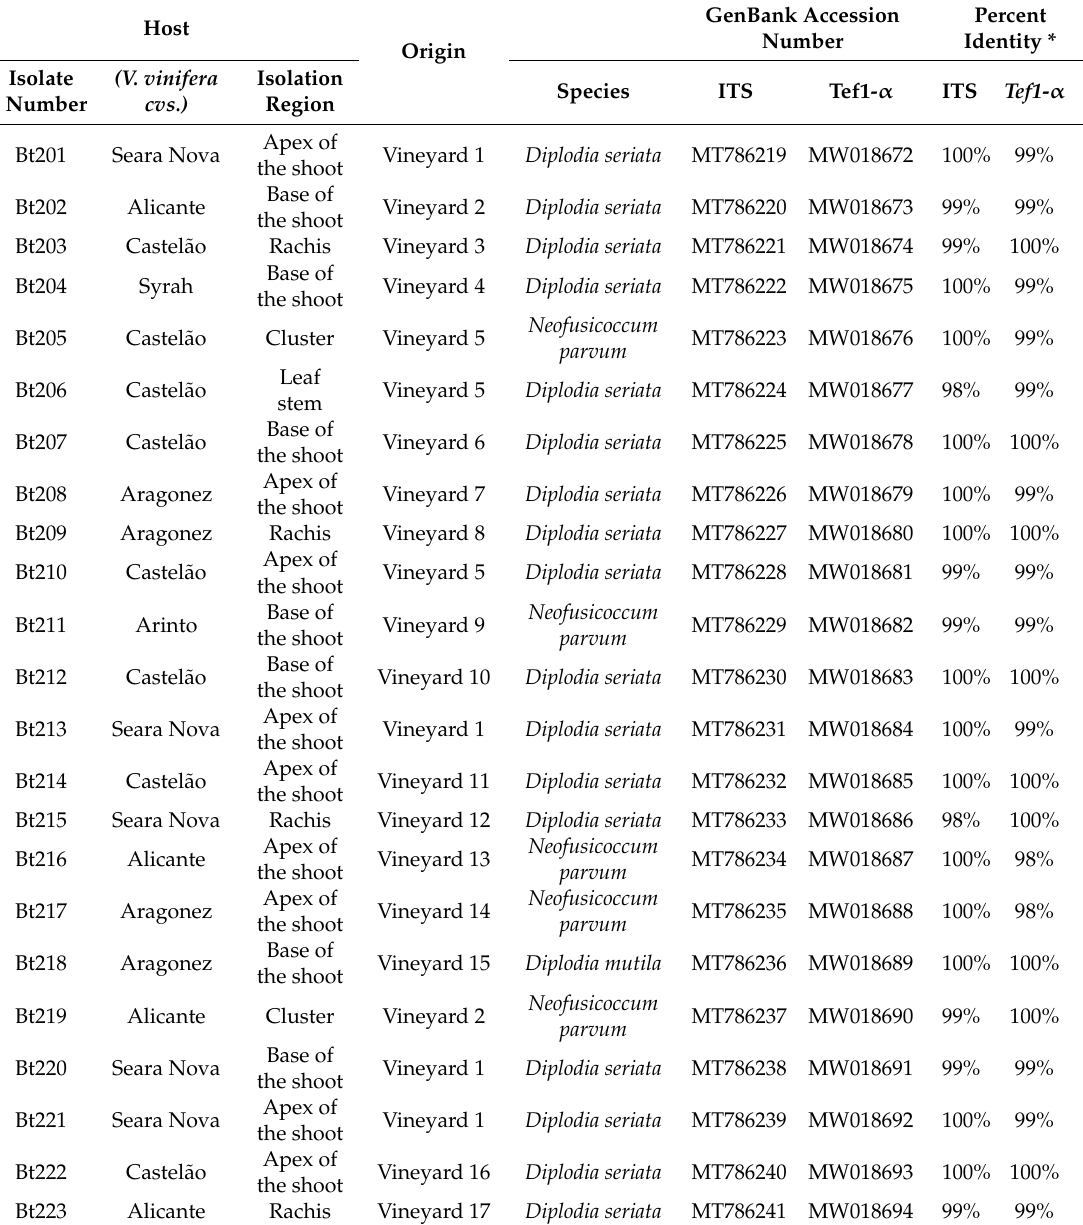
Table 1. Botryosphaeriaceae isolates obtained during the study, respective GenBank accession numbers, and percent identity when compared to reference